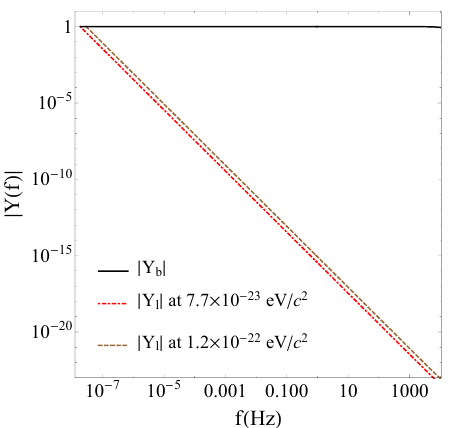
Figure 1. The absolute values of the response functions for the longitudinal ( | Y l ( f ) | ) and transverse breathing ( | Y b ( f ) | ) polarizations for aLIGO if the mass of ϕ is 1.2 × 10 − 22 eV/ c 2 [1] (brown dashed curve) or 7.7 × 10 − 23 eV/ c 2 [3] (red dot-dashed curve). | Y b ( f ) | is given by the solid black curve.